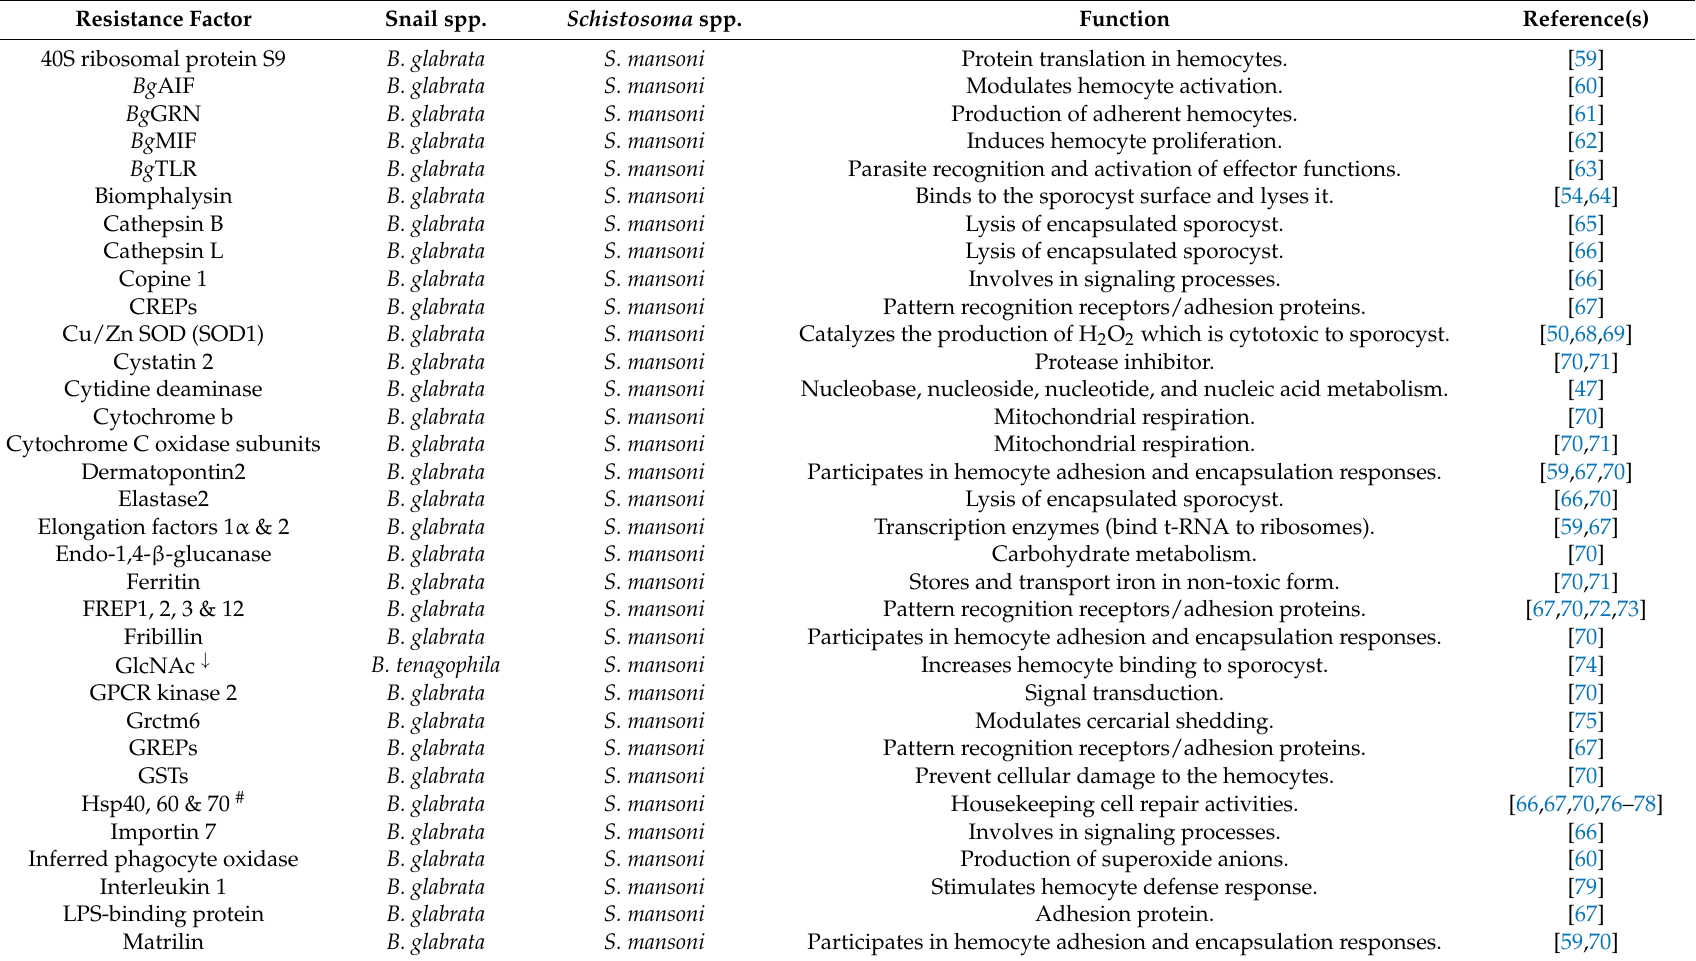
Table 1. Putative genes and proteins conferring Biomphalaria resistance to Schistosoma infection. Resistance